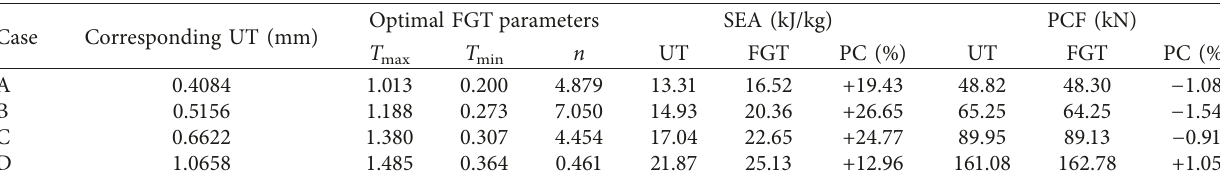
PC: percentage change of SEA and PCF for FGT compared to that of UT.